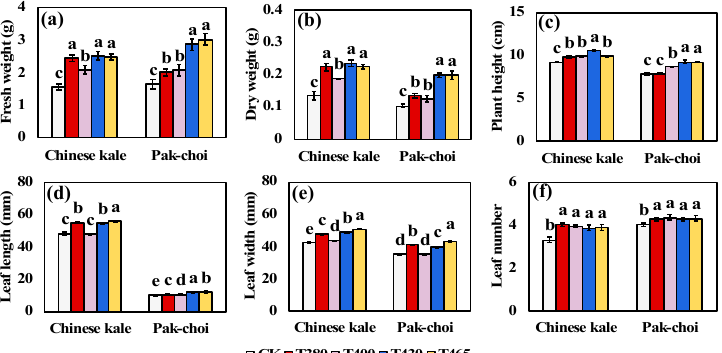
Figure 1. Agronomy traits of Chinese kale and pak-choi baby-leaves under supplementary different wavebands of blue and UV-A light. The fresh weight ( a ), dry weight ( b ), plant height, ( c ) leaf length ( d ), leaf width ( e ), and leaf number ( f ) of two baby-leaves. Different letters ( a – e ) upon the bar plots indicate significant difference at p < 0.05 using one-way analysis of variance with Duncan’s multiple-range test.